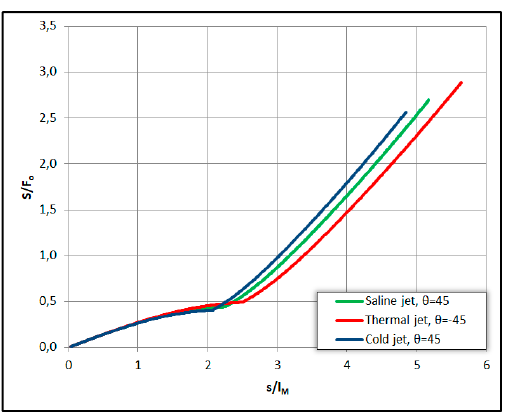
Figure 13. Comparison between negatively buoyant jets regarding their average dilution S/F o